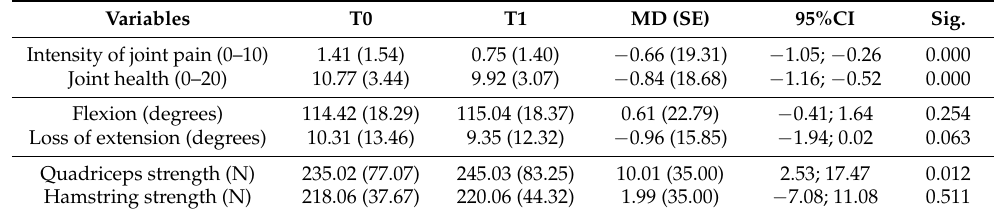
Table 2. Means (standard deviations) and changes evaluated in the different